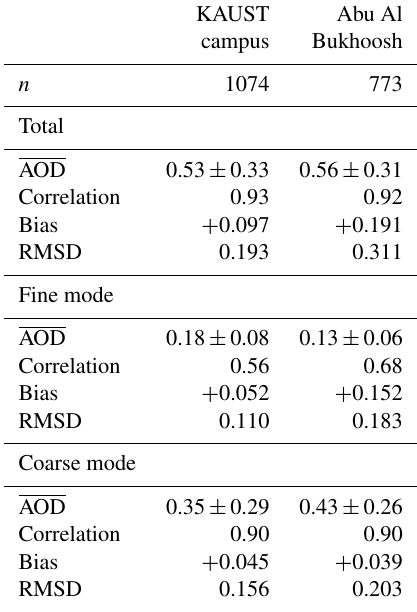
Table 2. Comparison statistics between fine- and coarse-mode AERONET and MODIS AODs at 500nm, at KAUST and at Abu Al